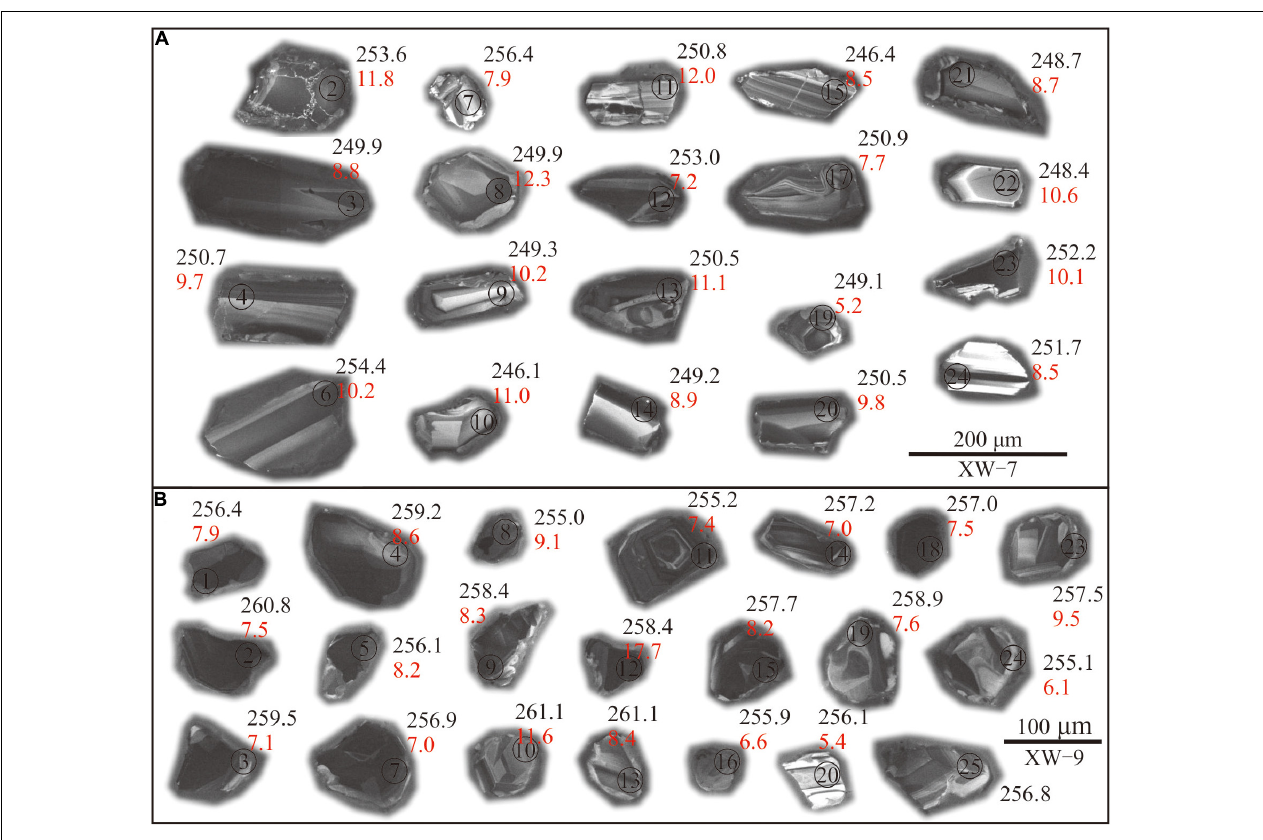
FIGURE 4 | Cathodoluminescence images of selected zircon crystals from the Xiwanggou (A) and gabbro (B) . Circles are laser beam targets. The black numbers are 206 Pb/ 238 U ages (Ma), and the red numbers are ε Hf( t )